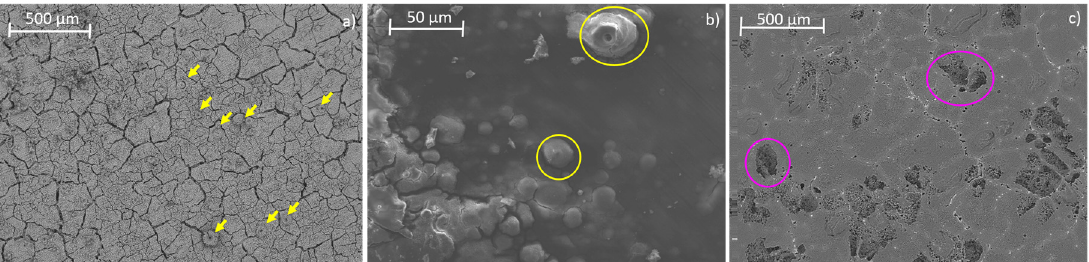
Figure 4. SEM images of corroded surface of as-cast ( a ) Mg-0.38Ga-1.5Zn and ( b ) Mg-1.5Ga-6Zn alloys after 168 h of immersion in SBF, ( c ) as-cast Mg-1.5Ga-6Zn alloy after removing corrosion products.